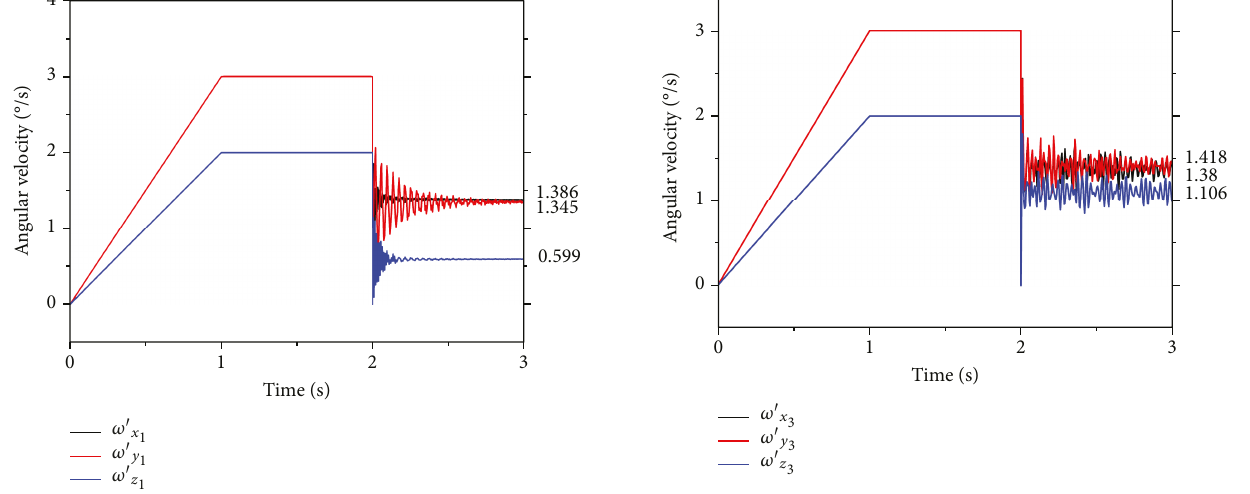
′ , ω ′ , and ω ′ when ω y 3 z 3 3